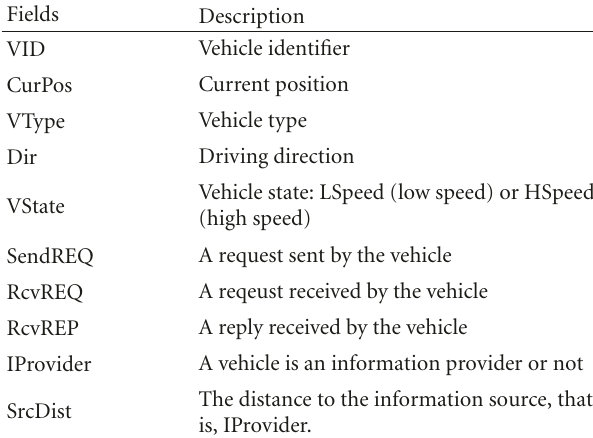
Table 1: The format of vehicle information and NT